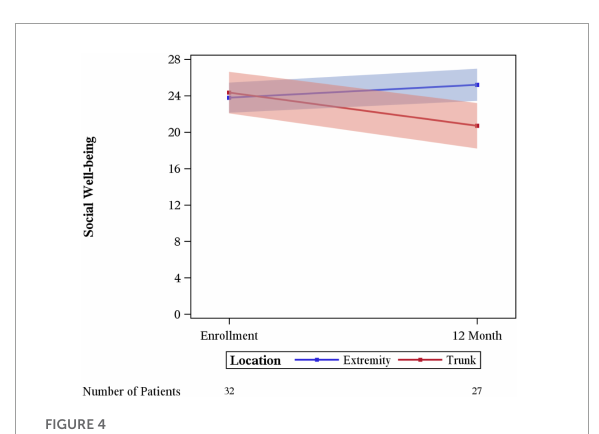
FIGURE4 Changes in social wellbeing by anatomic